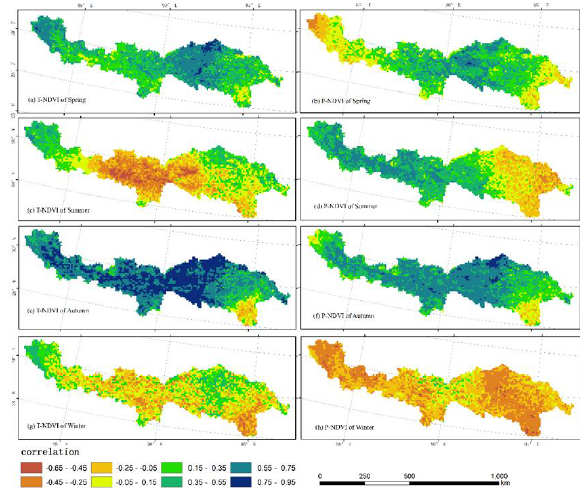
Figure 8. Spatial pattern of correlation between NDVI